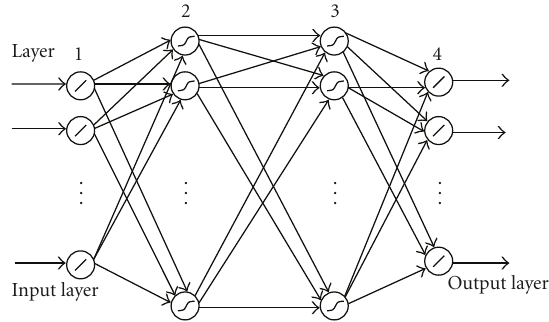
Figure 2: A 4-layer mapping neural network of size 12 L 24 N 24